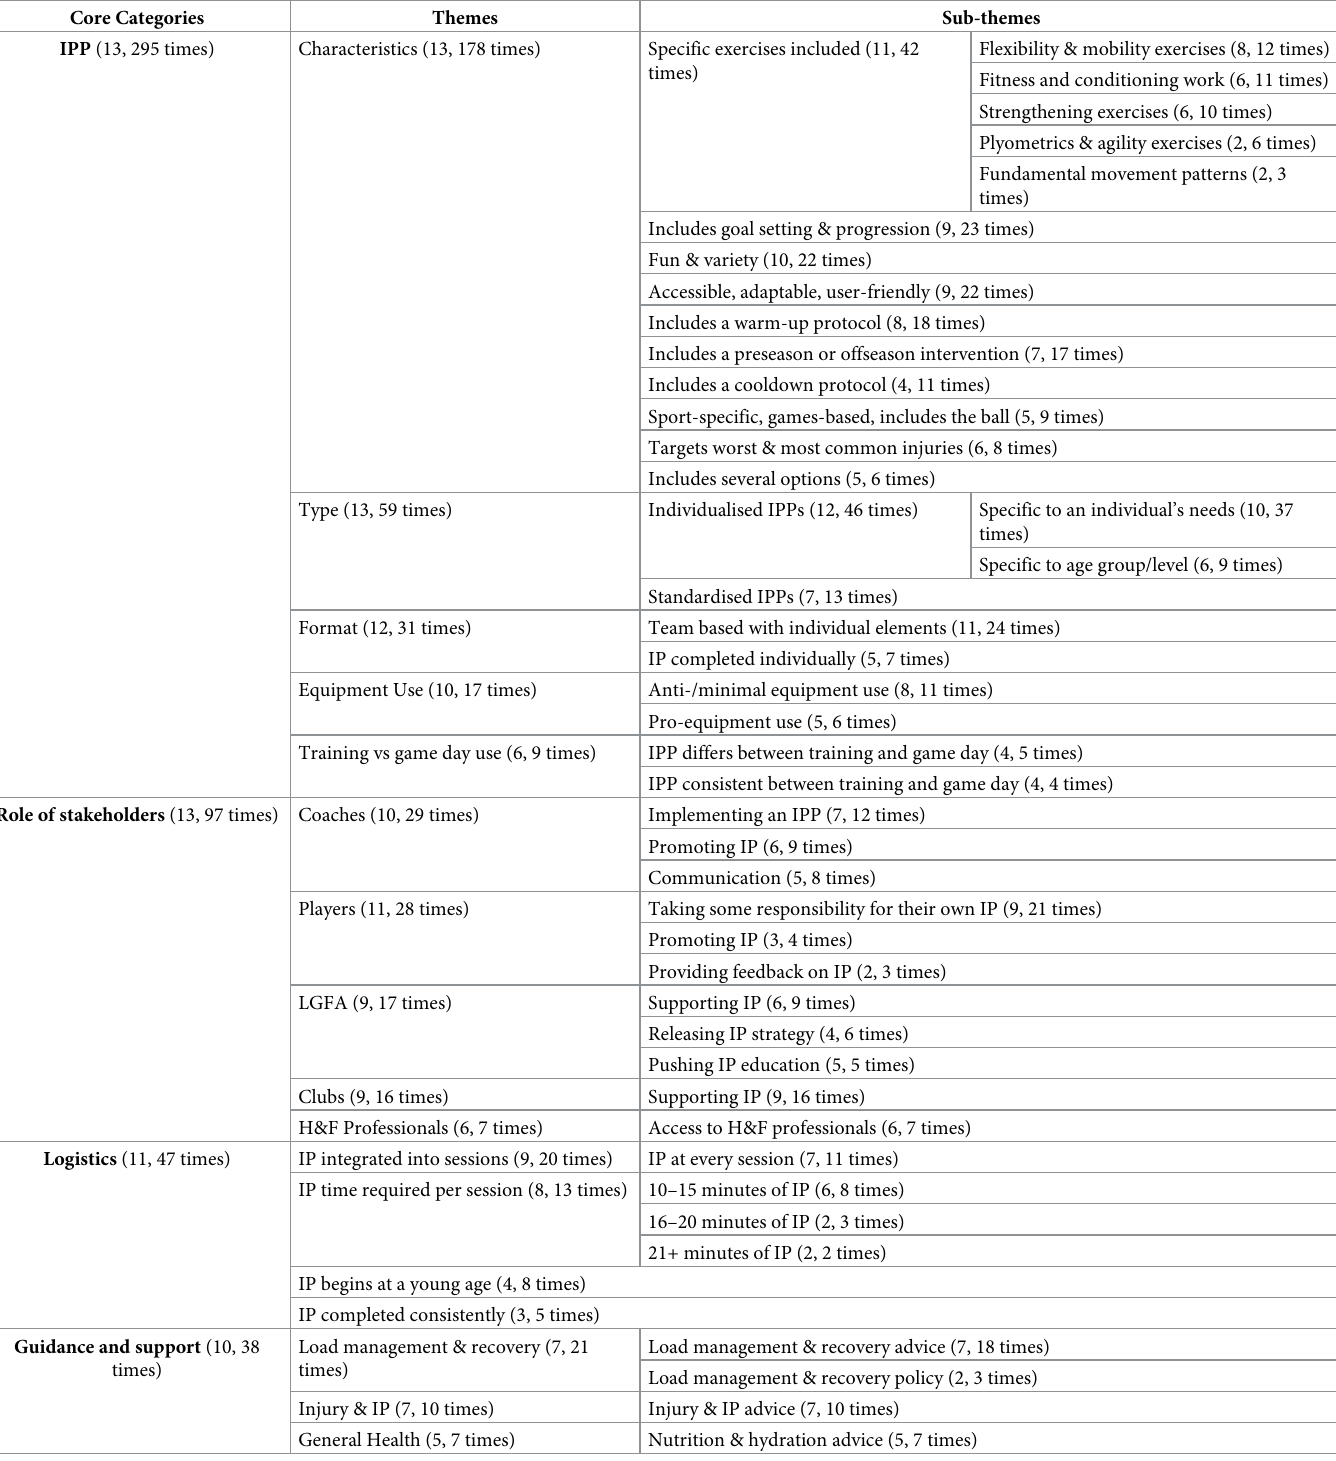
Table 1. Core categories, themes, and sub-themes surrounding coaches’ injury prevention strategy preferences (no. of coaches, no. of